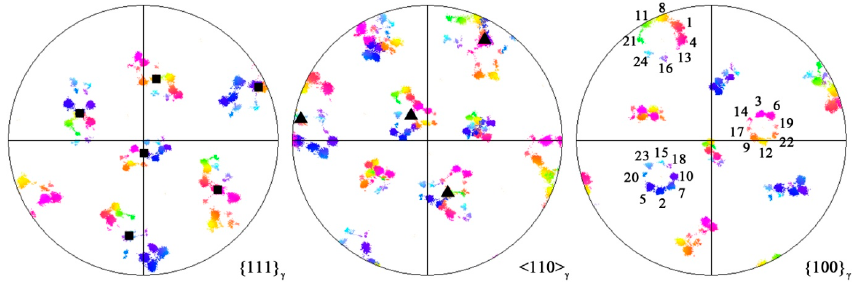
Figure 7. Pole figures for the γ phase in Figure 2a. In comparison with those in Figure 4b, a Blackburn OR and a K-S (Kurdjumov–Sachs) OR are evident. The OR-related planes/axes are marked by cubic/triangular symbols. The twenty-four γ variants are indicated in the {100} γ pole figure.